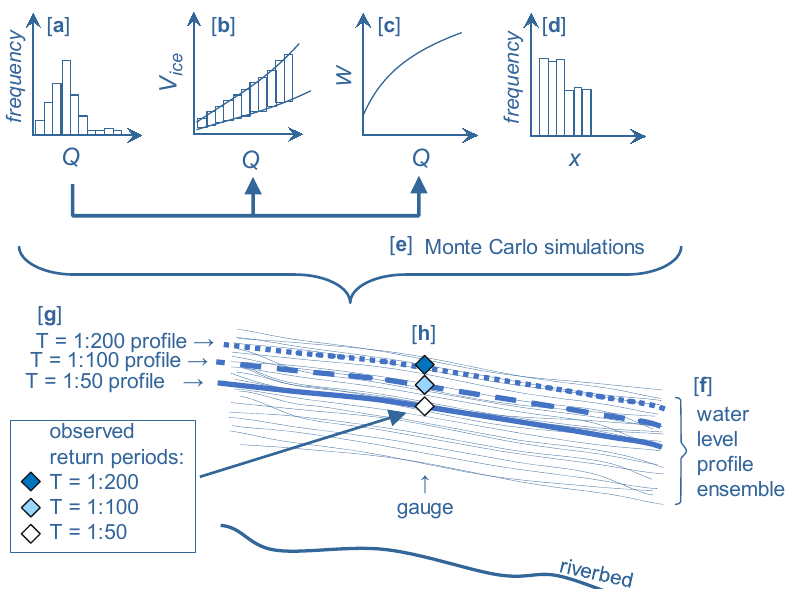
Figure 19. Conceptualization of the stochastic modelling framework for ice-jam flood hazard assess- ment; explanations for each subfigure are provided in the main text (drawn by the first author). Parameters are generally uniform distributions between minimum and maximum values determined through calibration.